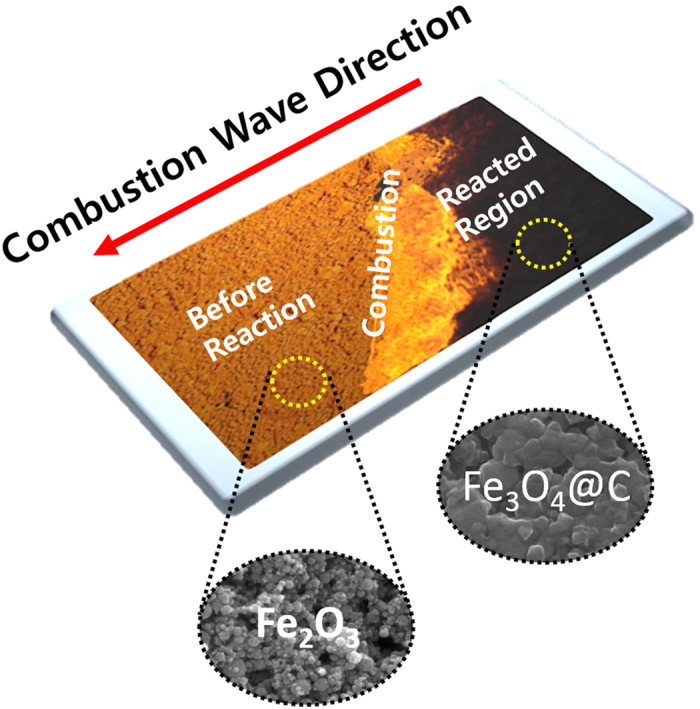
Scheme of one-step phase transformation from Fe2O3 to Fe3O4@C via combustion wave in the hybrid composite of Fe2O3 nanoparticles and chemical fuel.